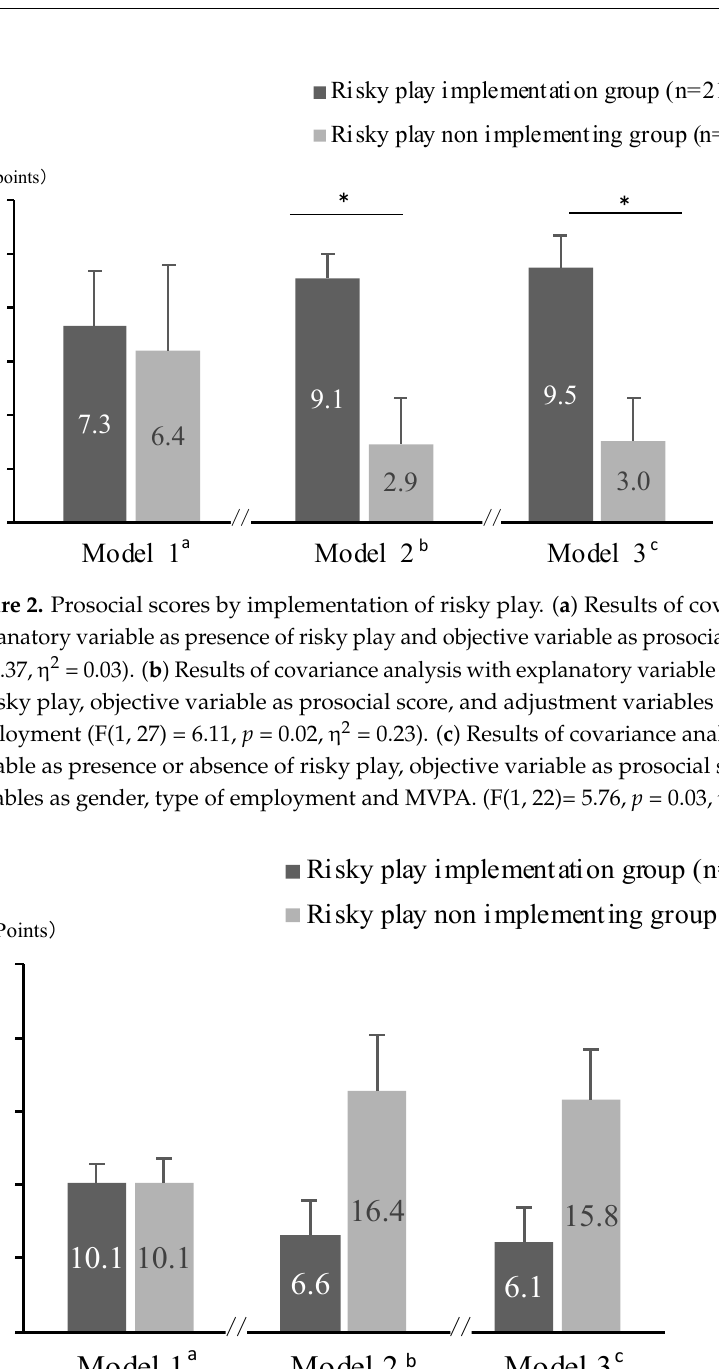
Figure 3. Total difficulty scores by implementation of risky play. ( a ) Results of covariance analysis